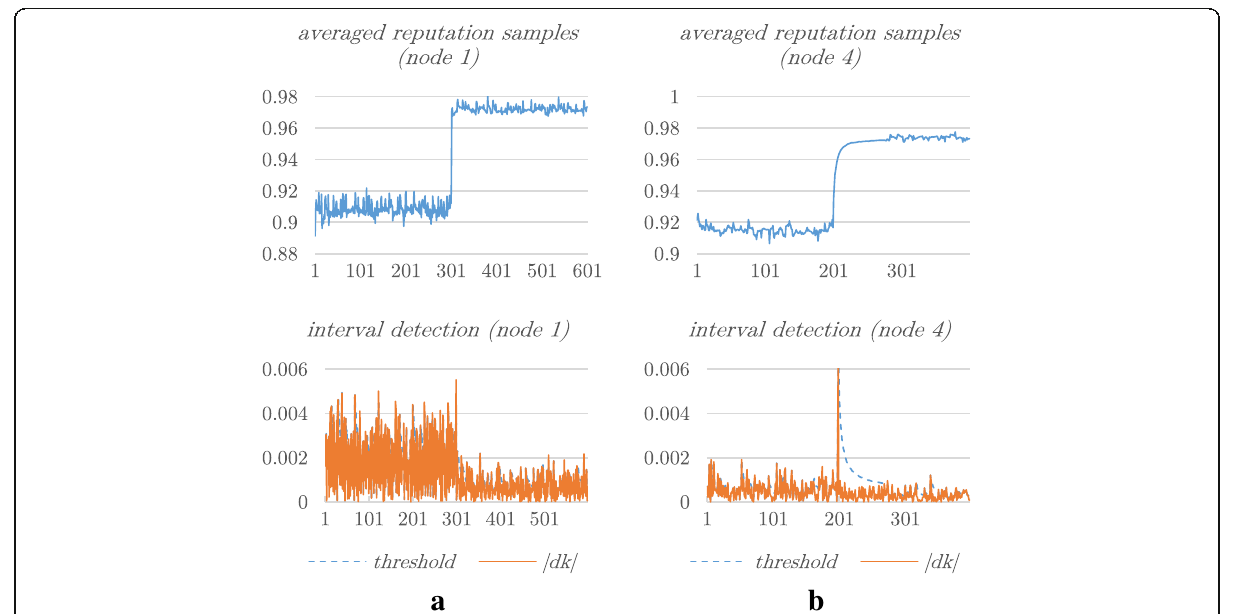
Fig. 9 Average value of the samples (figures at the top) and interval detection (figures below) when β =0.1 and F =1: a for node 1 and b for node